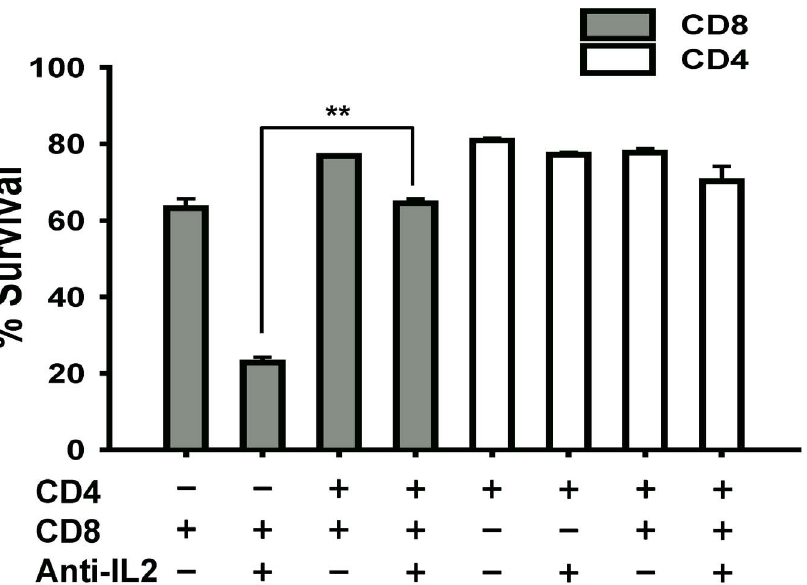
Figure 3. CD4 + T cells rescue the survival of CD8 + T cells upon co-culture in a trans-well. CD4 + CD25 2 (1 6 10 5 ) and CD8 + CD25 2 (1 6 10 5 ) T cells were isolated from wild-type B6 mice, and were cultured in the upper and lower chamber of a 24-well transwell plate respectively. Both populations of cells in upper and lower chambers were activated with 1:1 (cells:beads) ratio of Dynabeads (Mouse T-activator CD3/CD28). In some wells, the two populations were cultured alone with Dynabeads in the lower chamber as indicated in the figure. Some culture wells were supplemented with 10 m g/mL anti-IL-2 mAb as shown in the figure. At 48 hrs post-culture, cells were harvested and stained with PI to analyze percent survival by flow cytometry. The bars (n=3) show the frequency of PI negative cells within the CD4 + (white bars) and CD8 + (grey bars) T cells. The figure shows results from one representative experiment which was repeated three times with similar results. Bars indicate average value 6 SD obtained from three culture wells (technical triplicates) in each experimental group (**denotes p , 0.005).